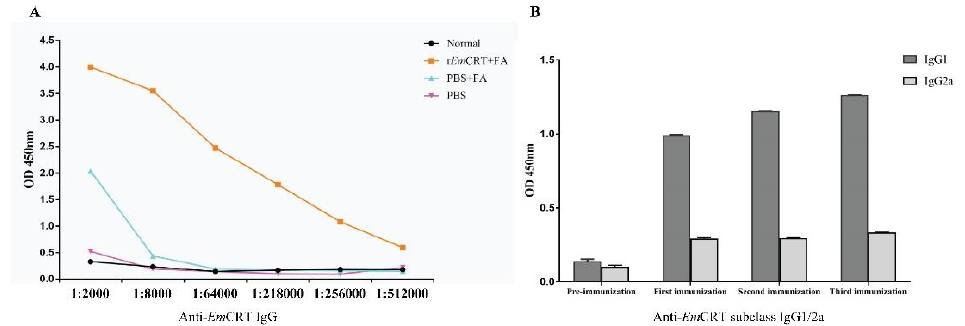
Figure 5. Antibody responses to the immunization with r Em CRT. ( A ) Total anti- Em CRT IgG titers in sera of all groups mice after last immunization. ( B ) OD450 value of anti- Em CRT IgG1 and IgG2a in sera of immunized mice with dilution 1:200. The values are presented as the arithmetic mean of five mice in the r Em CRT group ± standard error.